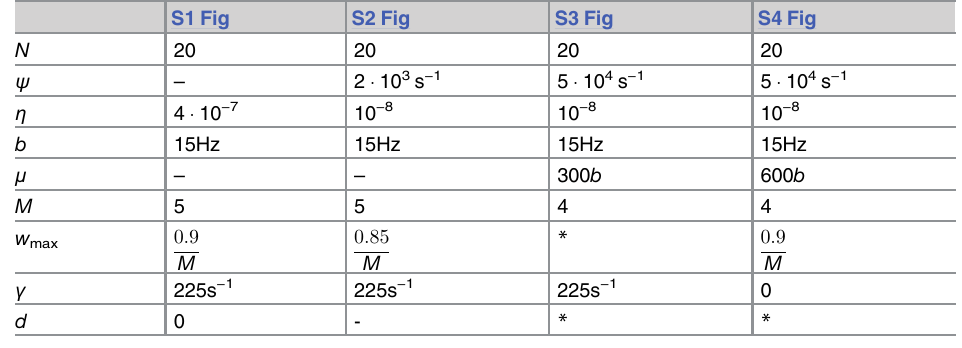
Table 3. Supplementary